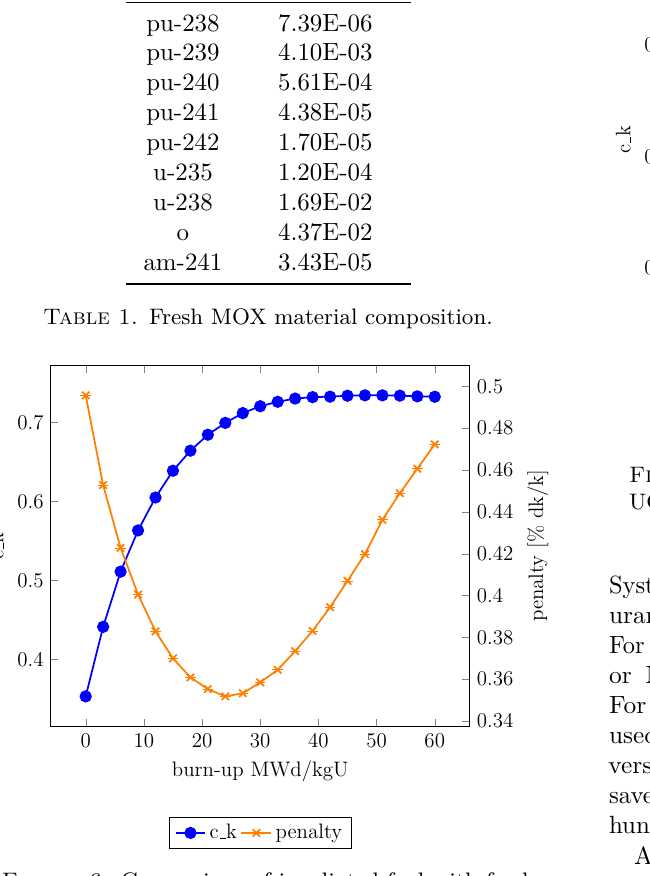
Figure 6. Comparison of irradiated fuel with fresh MOX fuel.